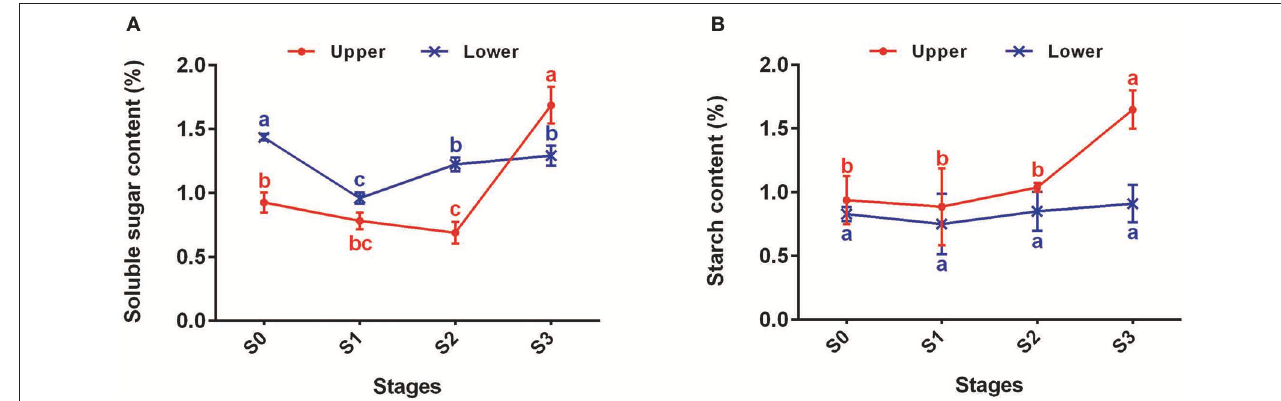
FIGURE 5 | Changes of starch and sucrose contents of upper (red) and lower (blue) axils at different stages during bulbil formation. (A) Soluble sugar contents of upper and lower axils at different stages during bulbil formation. (B) Starch contents of upper and lower axils at different stages during bulbil formation. The x-axis represents different stages, and the y-axis shows content. Lines and error bars indicate means and standard deviations, respectively. Non-overlapping letters indicate significant differences ( p < 0.05) for the different stages.